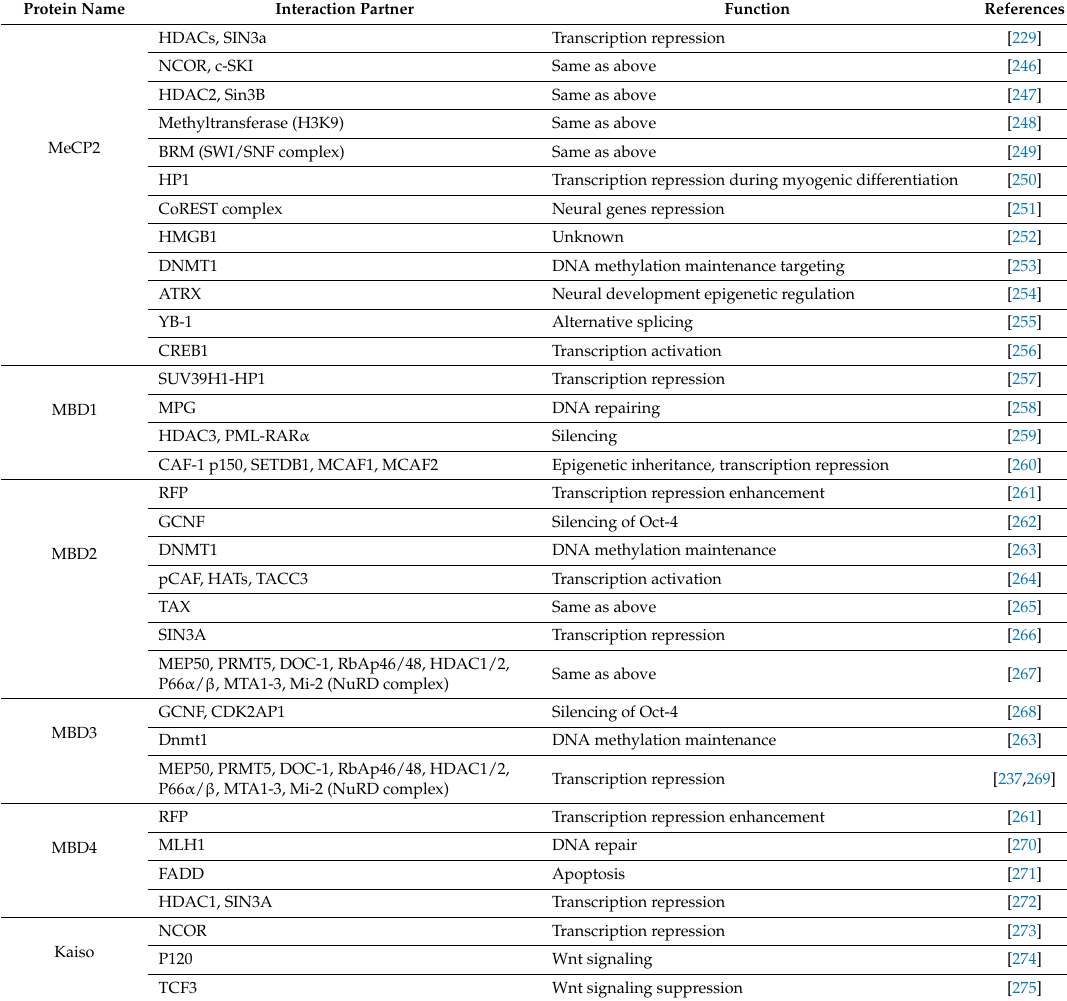
Table 6. Methyl binding proteins and their